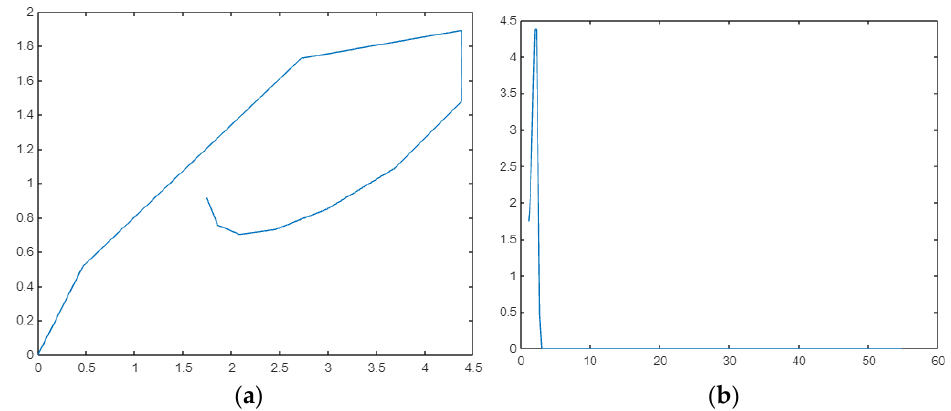
Figure 1. The results sample for phase diagram and cancerous cell populations according to the given constants in Appendix A: ( a ) The phase diagram; ( b ) Cancerous cell population.